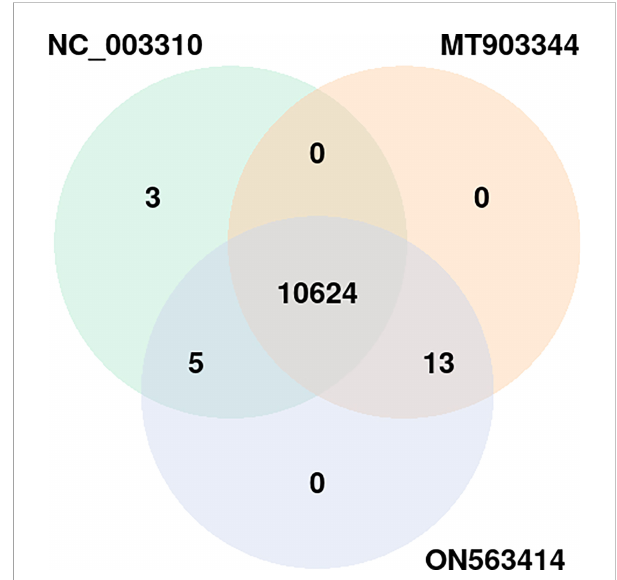
FIGURE 5 Distribution of common and unique gene ontology terms among the three strains of monkeypox virus (NC_003310, ON563414, and MT903344). p -value of the overlap region is 0.